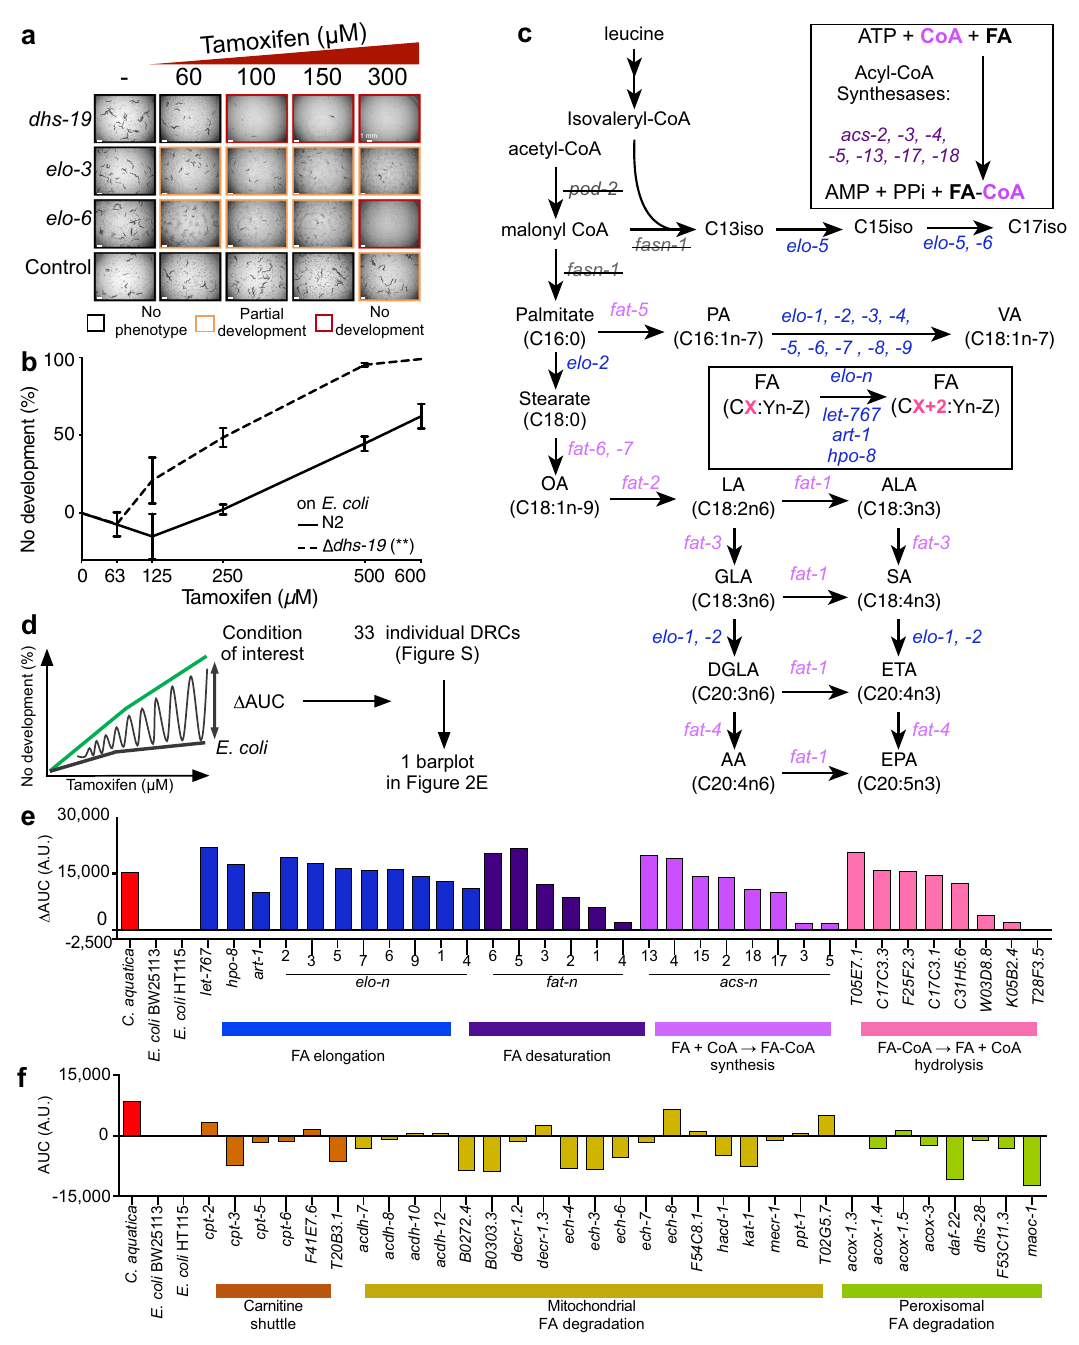
Fig. 3 | Host long-chain fatty acid synthesis modulates tamoxifen toxicity. a Screening ametabolic gene RNAilibraryidenti fi edthree genes( dhs-19 , elo-3 ,and elo-5 ) that, when knocked down, increase TAM toxicity. Animals were fed E. coli HT115 expressing double-stranded RNA as indicated. Control indicates E. coli containing vector control plasmid (pL4440). Bright- fi eld images were taken at 2x magni fi cation after a 48h exposureto tamoxifen. Scale bars:1mm.Representative results of one from three independent experiments. b Tamoxifen dose-response curves comparing Δ dhs-19 mutant animals to wild-type animals. Data were repre- sented as mean±SEM of three independent biological replicates. Statistical sig- ni fi cancewas assessed by performing a two-way Anova without a post hoc test, on